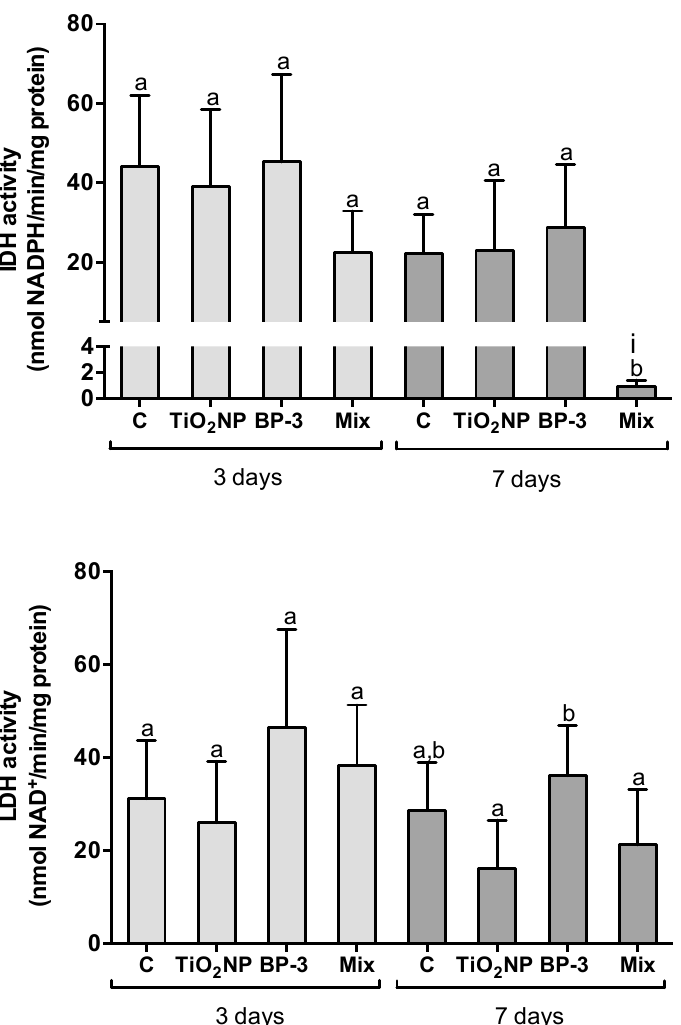
Figure 5. Metabolic profile of the liver of S. maximus assessed by isocitrate dehydrogenase (IDH) and lactate dehydrogenase (LDH), 3 and 7 days after intraperitoneal injection of titanium dioxide nanoparticles (TiO 2 NPs; 3.0 µ g TiO 2 NP per g fish weight), oxybenzone (BP-3; 3.0 µ g BP-3 per g fish weight) or their mixture (Mix), as well as the respective control group (C). Different lower-case letters denote significant differences ( p < 0.05). Significant interaction between TiO 2 NPs and BP-3 is depicted by (i) ( p < 0.05). Columns correspond to mean and error bars represent the standard deviation.